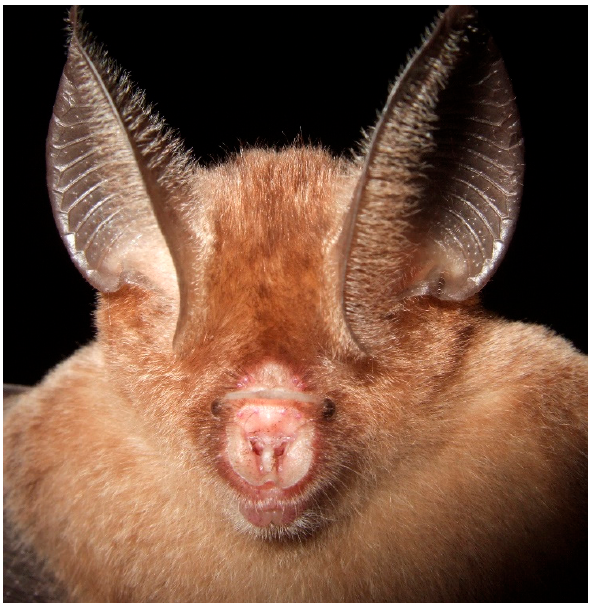
Figure 13. Hipposideros gentilis , adult male. Photograph by Vu Dinh Thong.